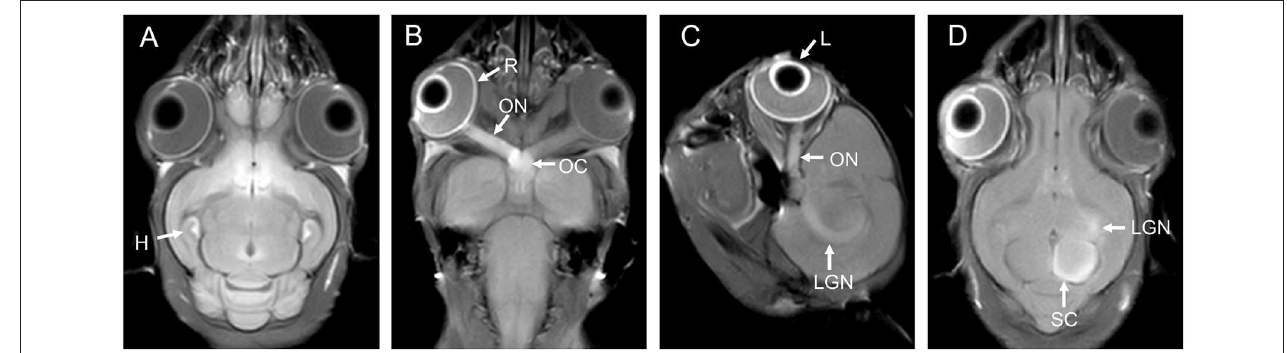
FIGURE 1 | (A) is the brain of a tree shrew in MEMRI after MnCl 2 intraperitoneal administration 24h. The hippocampus can be observed enhancement. (B–D) are the visual pathways of a tree shrew in MEMRI. MEMRI can be used to observe visual pathways from the retina, optic nerve, optic chiasm, lateral geniculate nucleus, and superior colliculus after intravitreal injection of MnCl 2 in a tree shrew (a kind of squirrel-like mammal which is the closest to primates). H, hippocampus; R, retina; L, lens; ON, optic nerve; OC, optic chiasm; LGN, lateral geniculate nucleus; SC, superior colliculus.